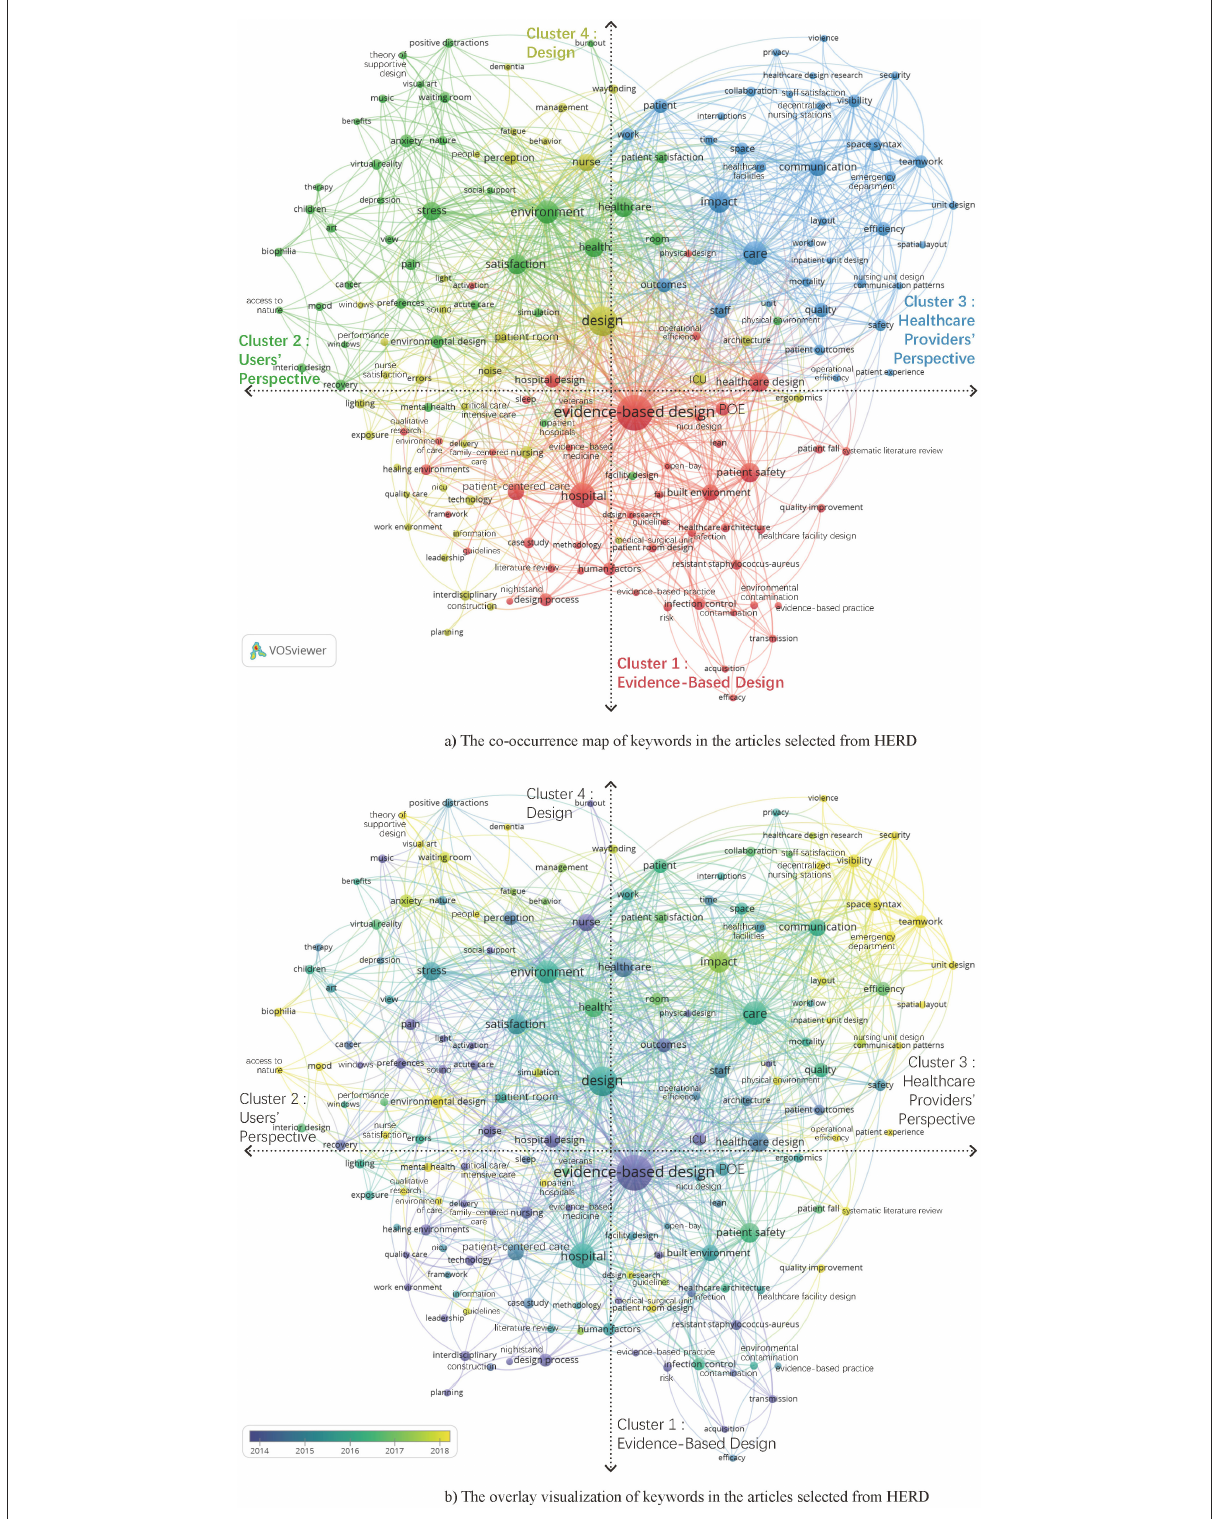
FIGURE2 Keyword analysis of the articles selected from HERD. (A) The co-occurrence map of keywords in the articles selected from HERD. (B) The overlay visualization of keywords in the articles selected from HERD.